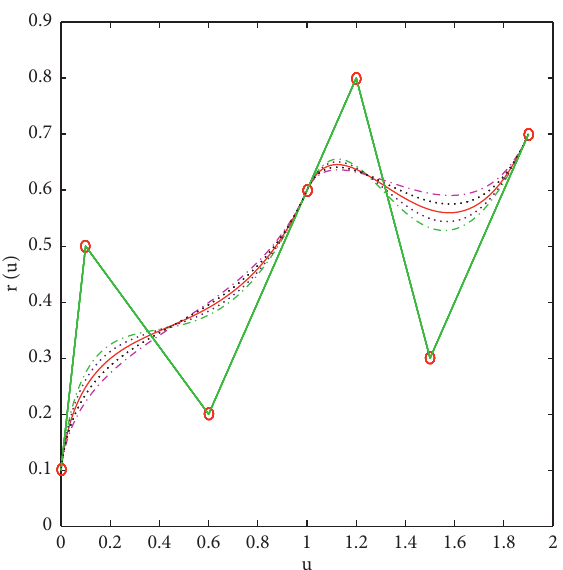
Figure 2: Open curve using CT-B´ezier basis